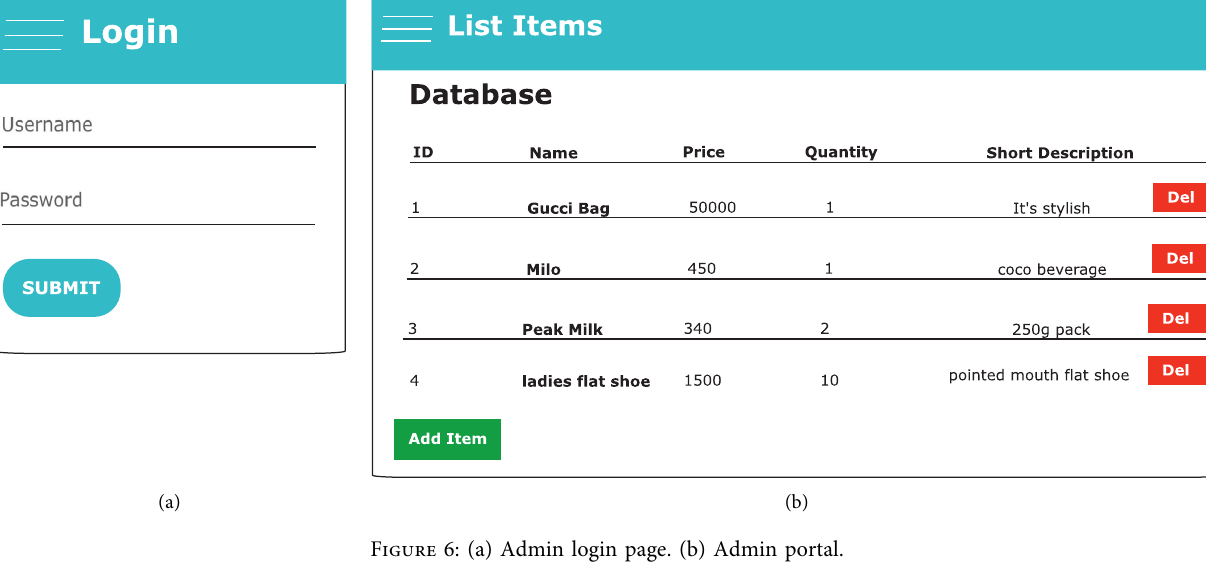
Figure 6: (a) Admin login page. (b) Admin portal.